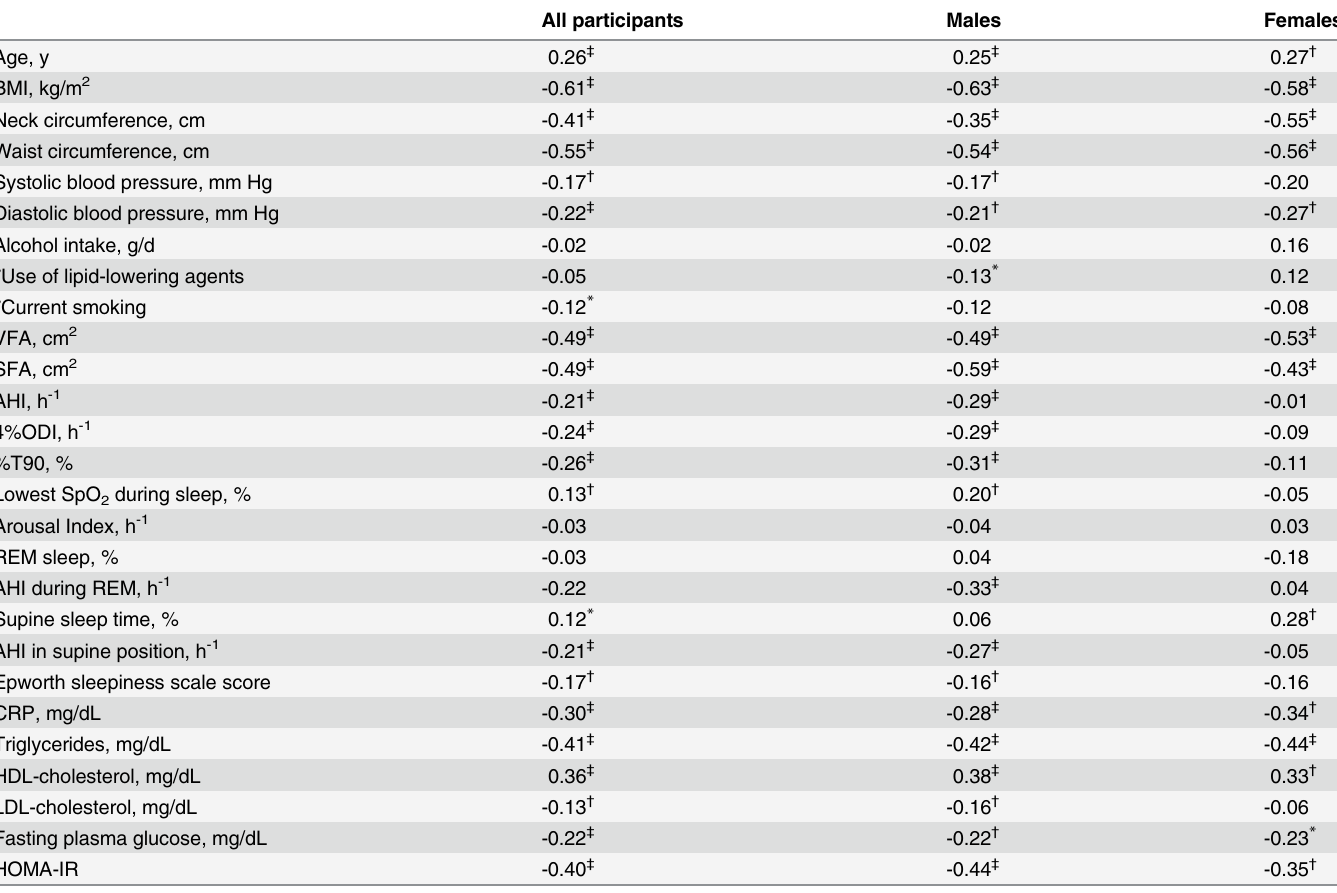
Table 2. Correlation coefficients of CT LFA in all participants and separately in males, and females. All participants Males Females Age, y